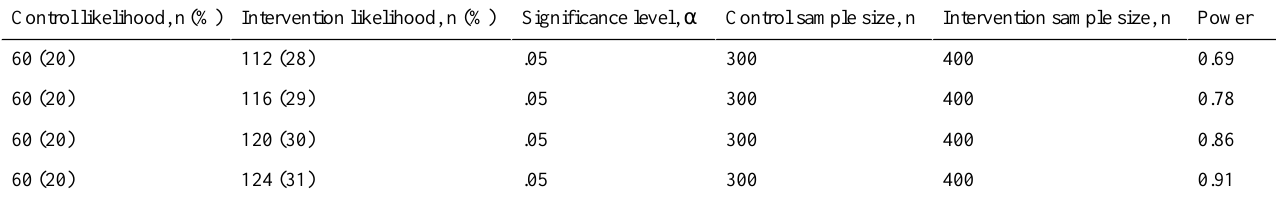
Table 5. Power calculations for intentions to switch methods, partner invitation intervention.